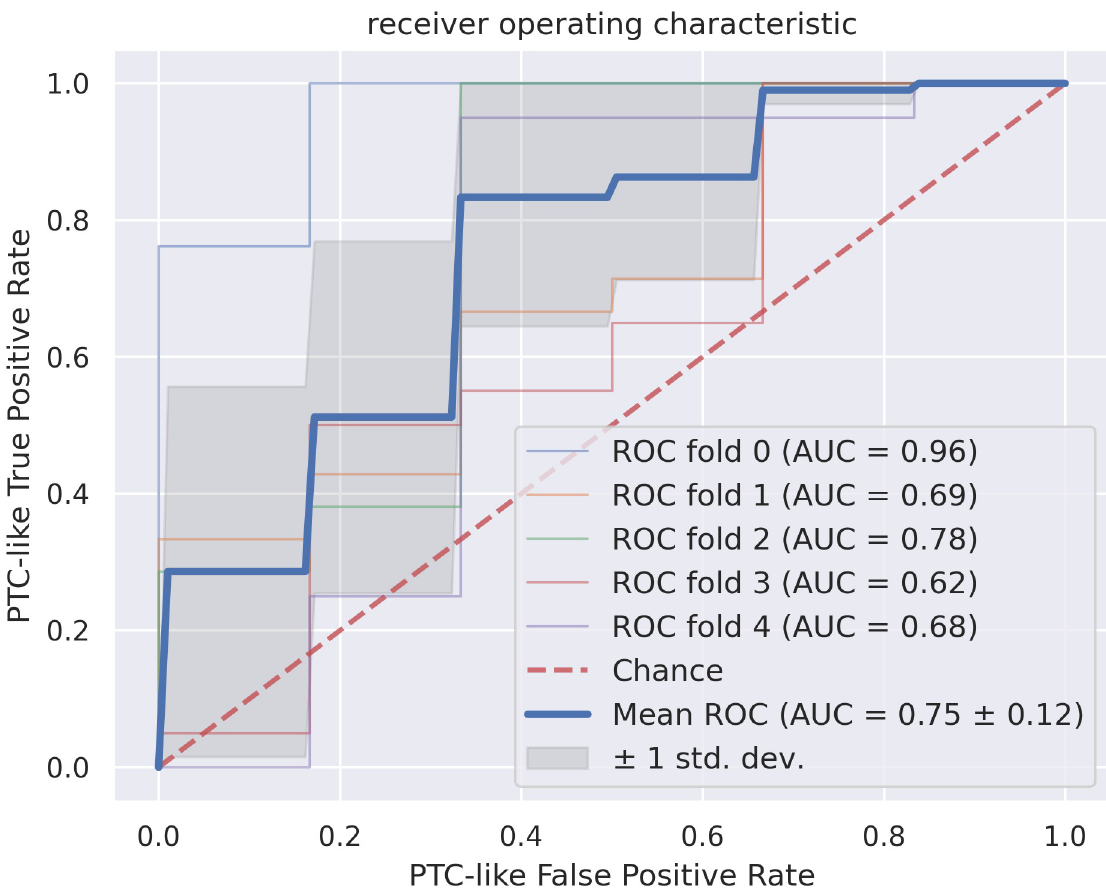
Fig 8. The receiver operating characteristic curves for the feature-based classification, where a true positive sample is a PTC-like sample classified as PTC-like. All cross-validation splits and the resulting area under curve (AUC) together with the resulting mean for the dataset are shown. The standard deviation around the mean is annotated in dark gray. The red dotted line corresponds to the classification by